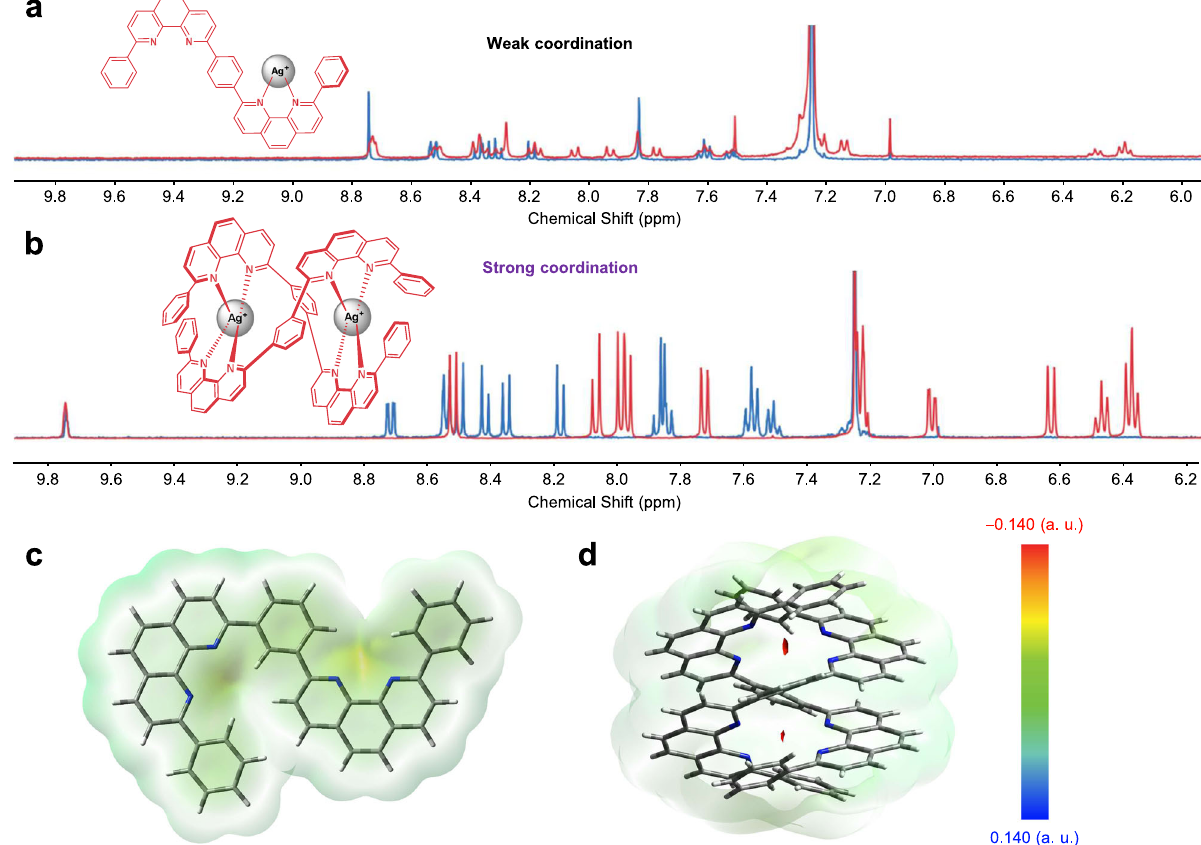
Fig. 2 The coordination reaction of different diphenanthroline ligands. a 1 H NMR spectra of the resulting products of p-dPPhen:AgNO 3 (molar ratio of 1:1) in CDCl 3 . b 1 H NMR spectra of the resulting products of m-dPPhen and AgNO 3 (molar ratio of 1:1) in CDCl 3 . c Electrostatic potential maps of monomolecular m-dPPhen. d Electrostatic potential maps of two m-dPPhen in a double-helical